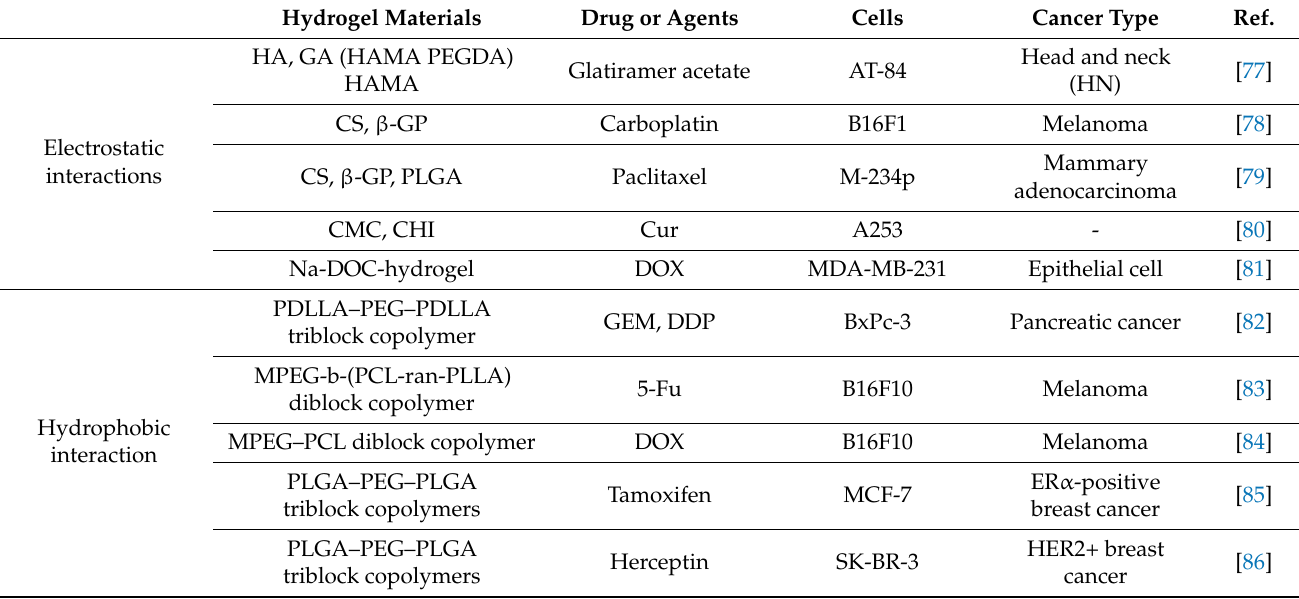
Table 1. Intratumoral injection using an injectable hydrogel through physical interaction with anticancer